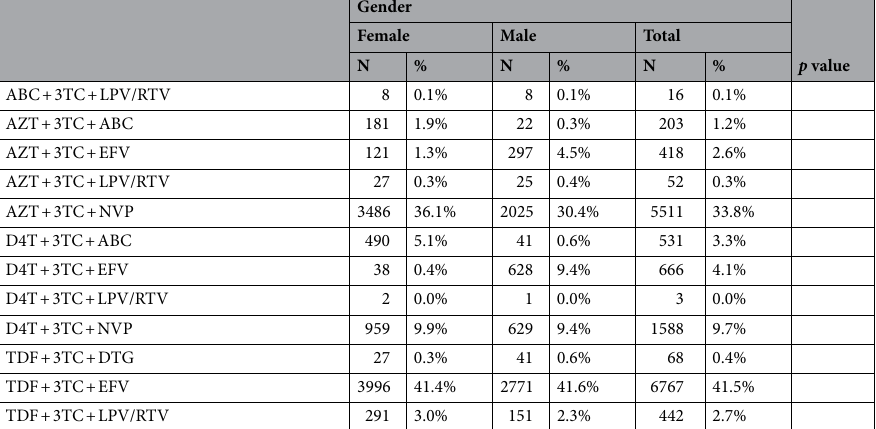
Table 2. Characteristics of HIV patients enrolled at Carmelo Hospital of Chókwè between January 1, 2002 and December 31, 2019 by Gender Status. 1 p values based on chi-squared test for any difference across groups over both gender status. ART antiretroviral treatment, ABC abacavir, 3TC lamivudine, EFV efavirenz, LPV/ RTV lopinavir/ritonavir, AZT zidovudine, D4T stavudine; NVP nevirapine, DGT